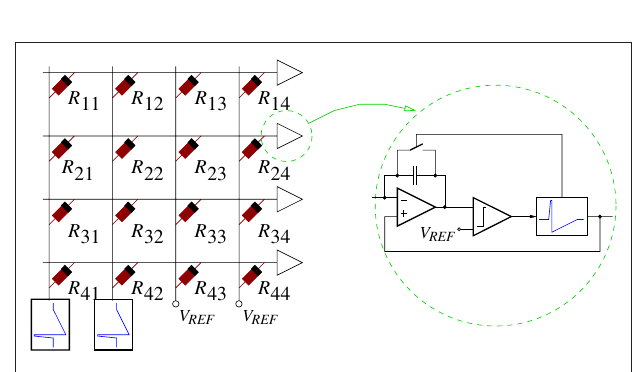
Figure 12 | Small feed forward memristive array simulated behaviorally with